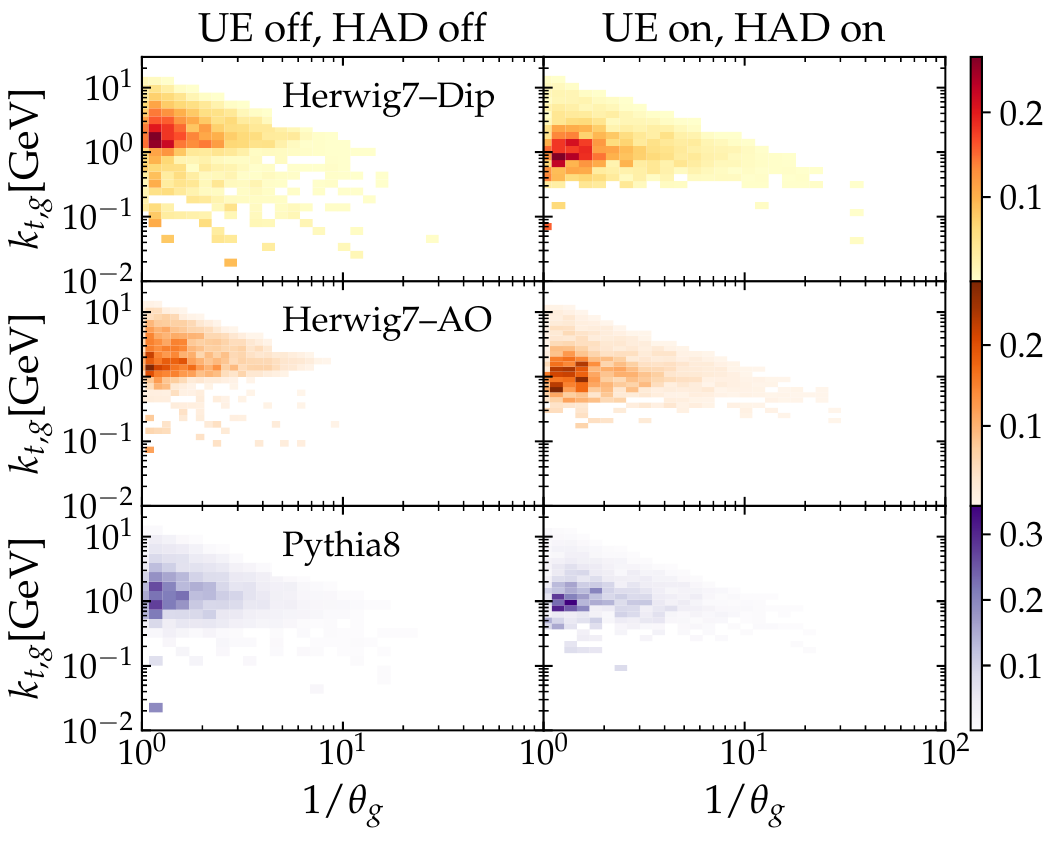
Figure 14 . Lund planes generated by the three Monte-Carlo setups used in this work, Herwig7-Dip (top), Herwig-AO (center) and Pythia8 (bottom), with ALICE kinematics and a =1